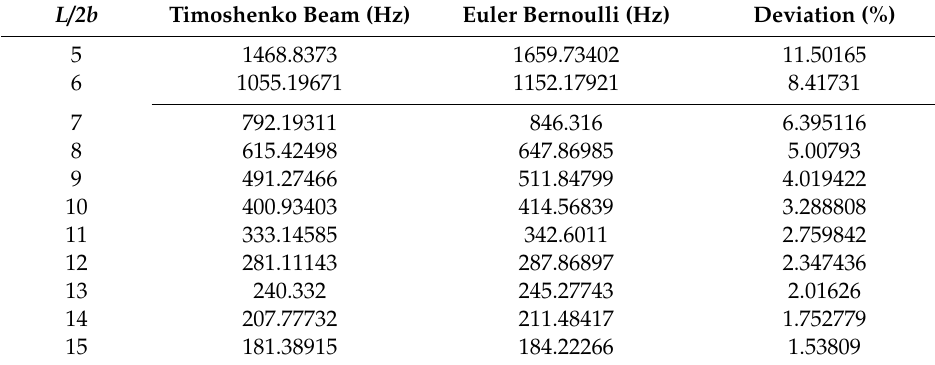
Table 2. Comparison of the fundamental natural frequency based on di ff erent theory ( Ω = 0).